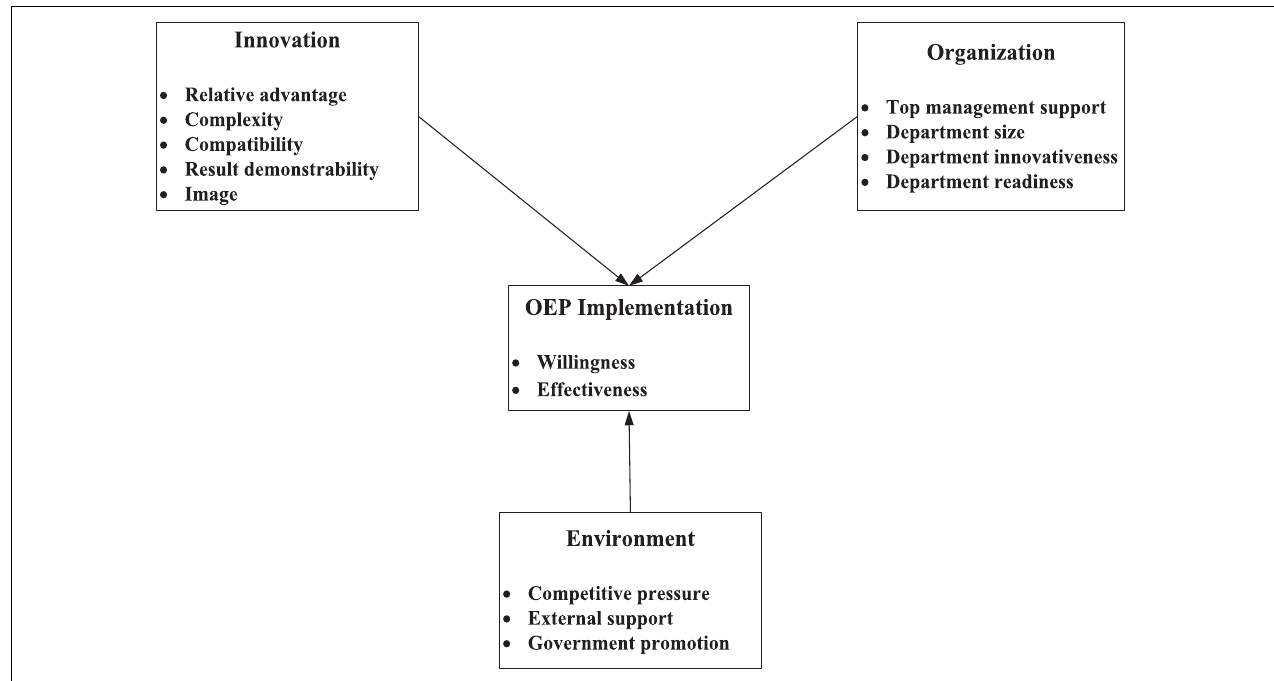
FIGURE 1 | The research model. The only factors significantly affecting departments’ willingness to implement OEP are assumed to be the factors driving the